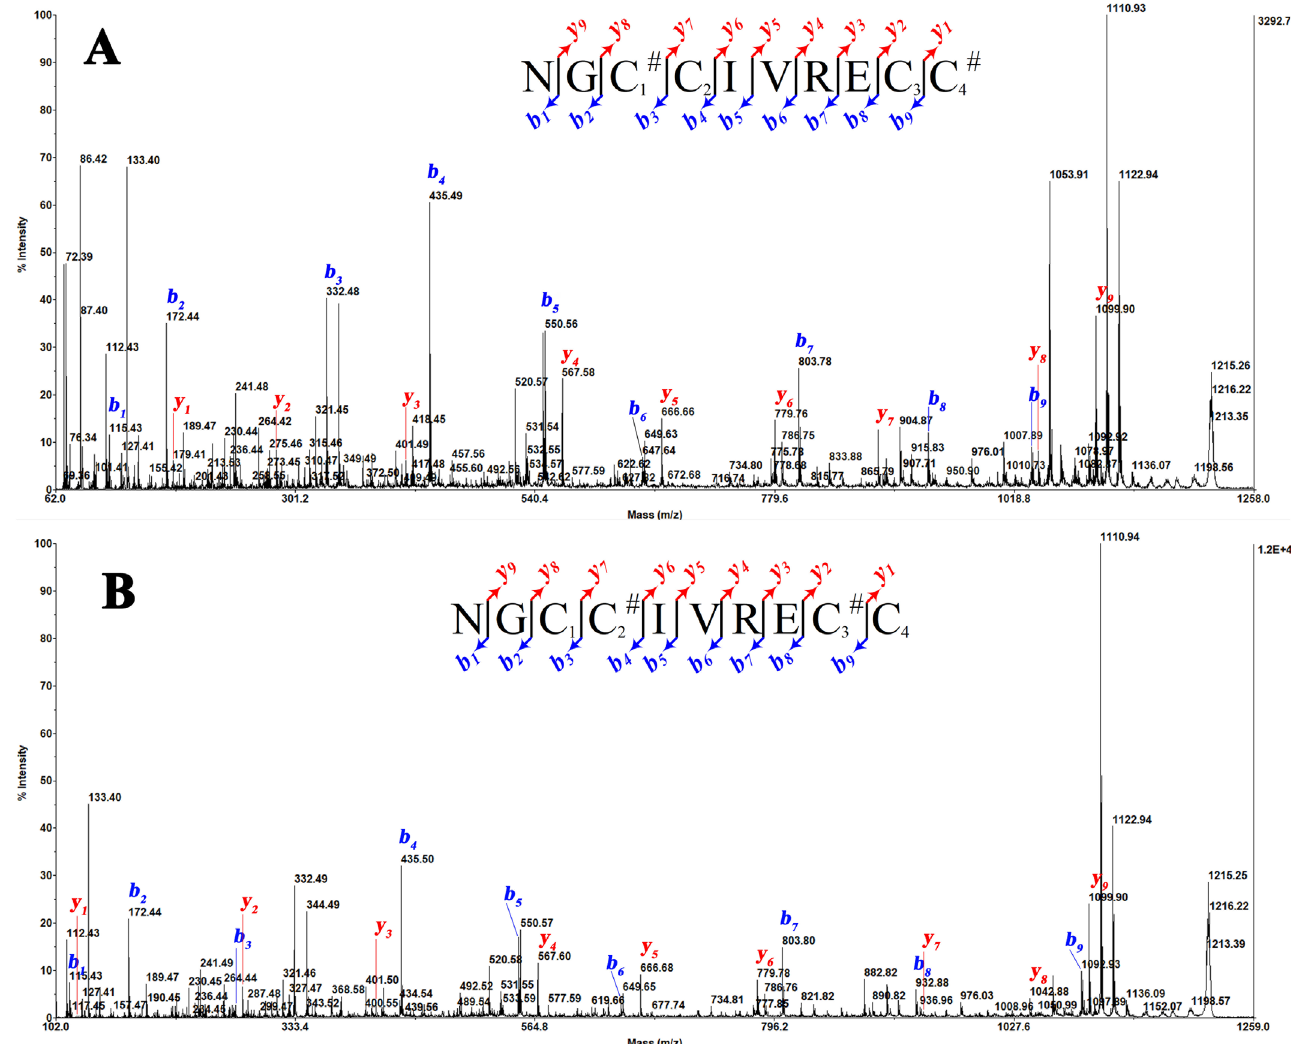
-C IAA-labeled Bn5a from experiments 2 3